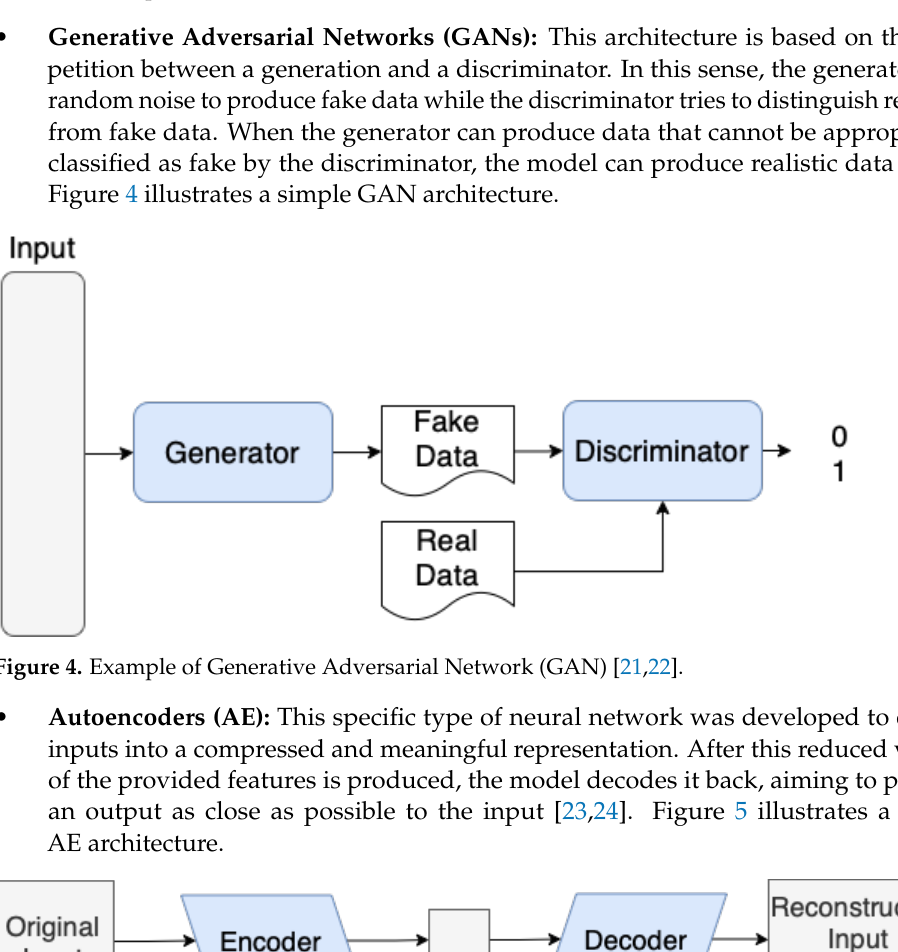
Figure 3. Example of Recurrent Neural Network (RNN) [19,20].